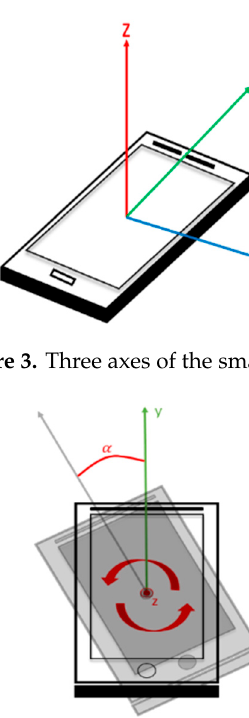
Figure 4. Angle of rotation of the z- axis of the mobile device.